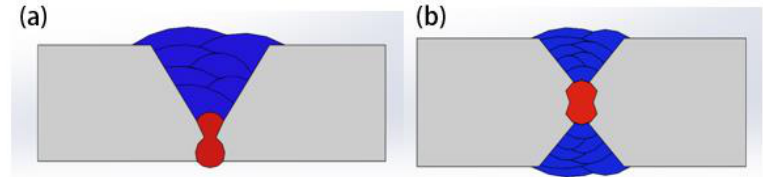
Figure 1. Schematic diagram of X and Y groove ( a ) Y-groove ( b )